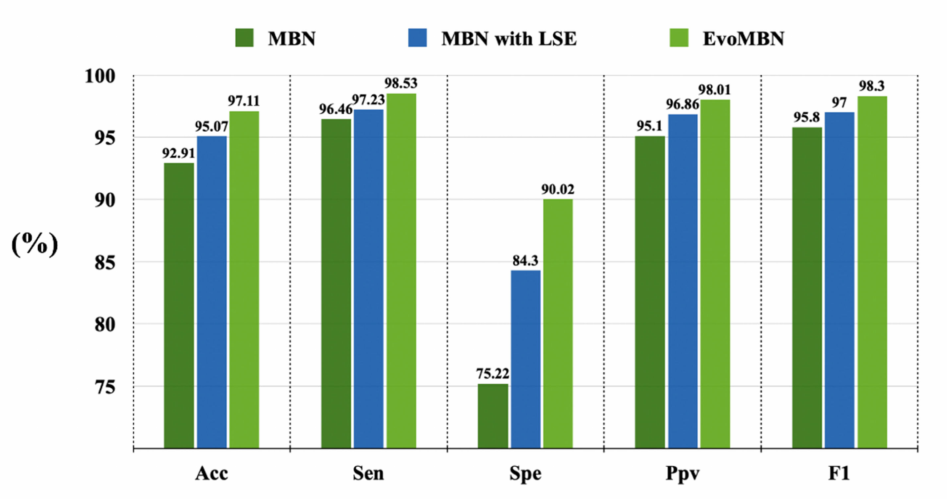
Figure 12. The results of the ablation experiment on MI